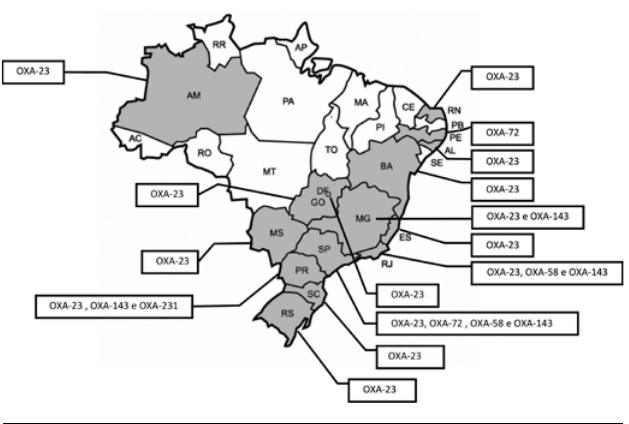
figurE 2 – Current overview of the spread of OXA -type carbapenemase producing A. baumannii isolates in Brazilian states (4-6, 18, 19, 24, 28, 40, 41, 52, 84-87, 96, 97, 139, 155, 156) States filled in gray indicate the occurrence of OXA- producing strains. OXA: